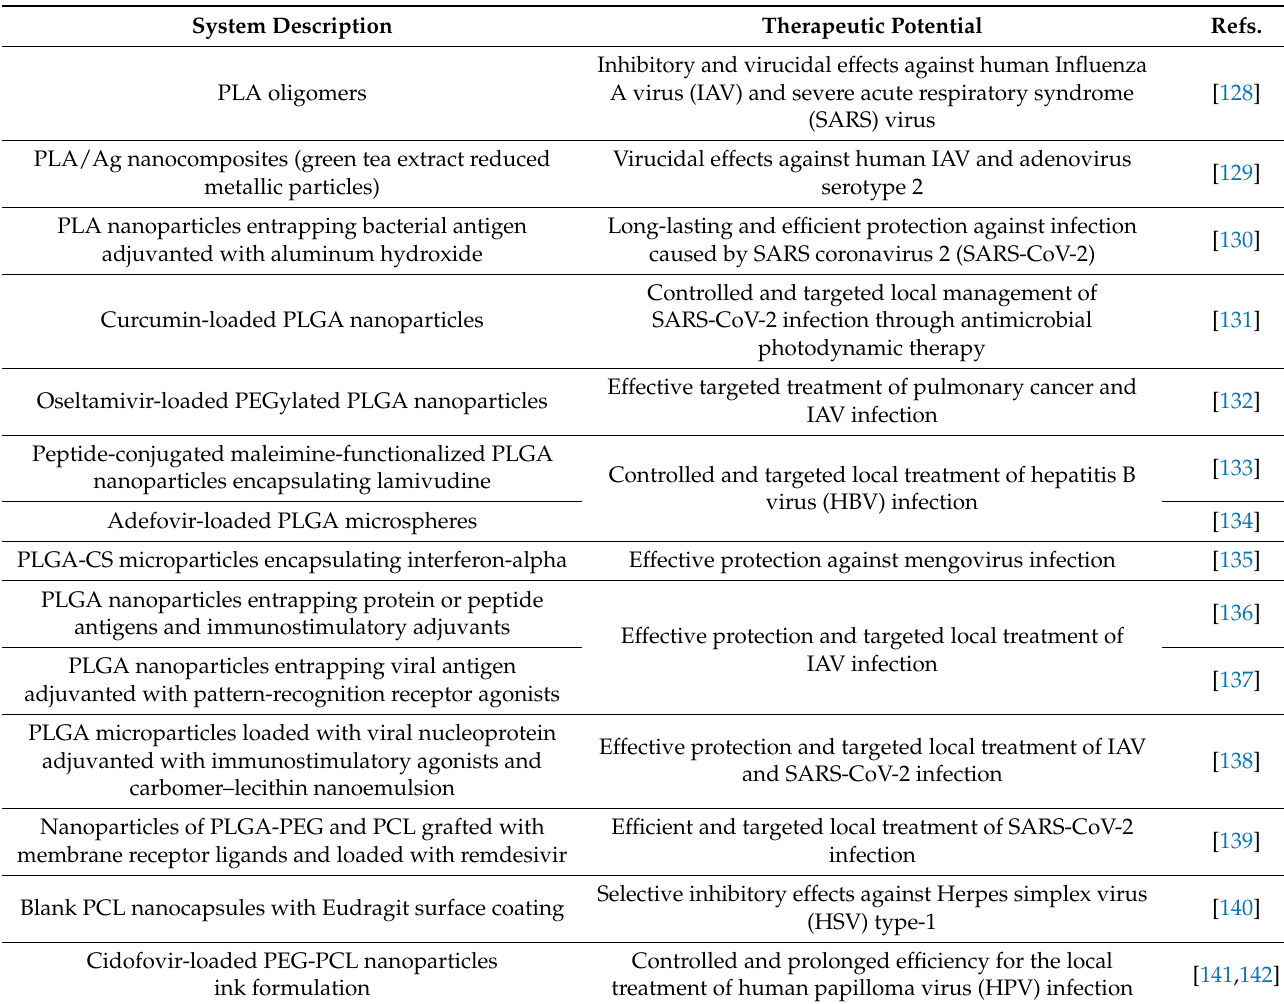
Table 1. Particulate biocompatible polyester-based antiviral